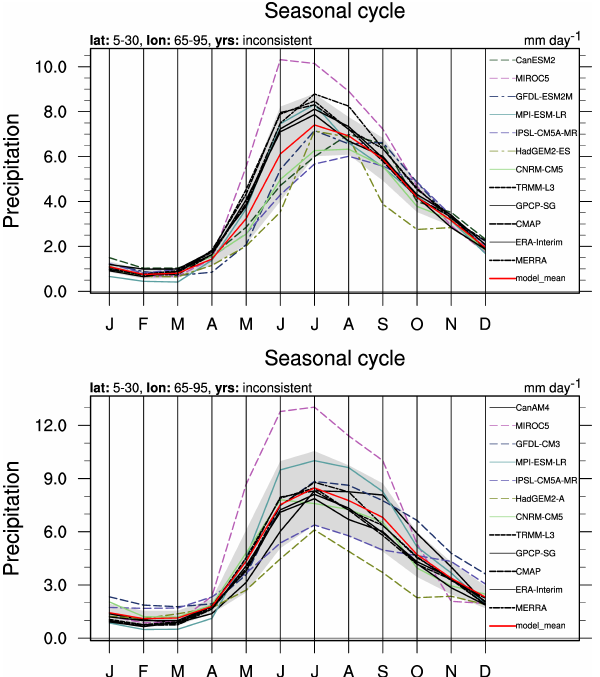
Figure 6. Seasonal cycle of monthly rainfall averaged over the In- dian region (5–30 ◦ N, 65–95 ◦ E) for a range of CMIP5 coupled models (upper panel) and their AMIP counterparts (lower panel), averaged over available years (models: 1980–2004; observations: 1998–2010). The grey area in each panel indicates the standard de- viation from the model mean, to indicate the spread between models (observations/reanalyses are not included in this spread). These il- lustrate the range of rainfall simulated particularly in AMIP exper- iments where there is no feedback between precipitation and SST biases that might moderate the rainfall biases (Bollasina and Ming, 2013; Levine et al., 2013). Some of the CMIP5 coupled models (e.g. HadGEM2-ES, IPSL-CM5A-MR) show a delayed monsoon onset that is not apparent in their AMIP configurations. This is re- lated to cold SST biases in the Arabian Sea which develop dur- ing boreal winter and spring (Levine et al., 2013). Produced with namelist_SAMonsoon.xml